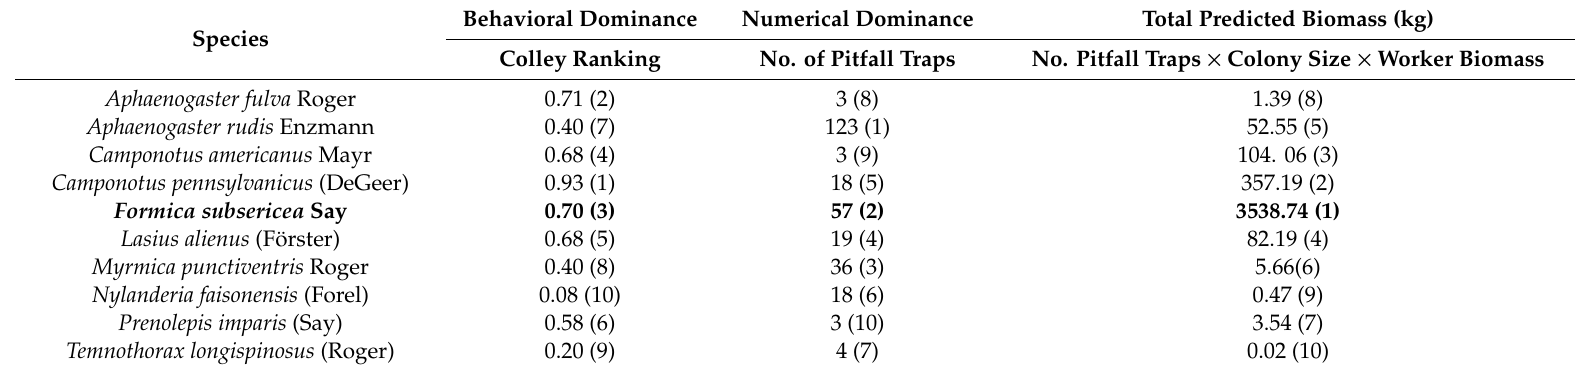
Table 2. List of species recorded both in pitfall trap and on baits in Great Smoky Mountains National Park. Behavioral Dominance Numerical Dominance Total Predicted Biomass (kg) Species Colley